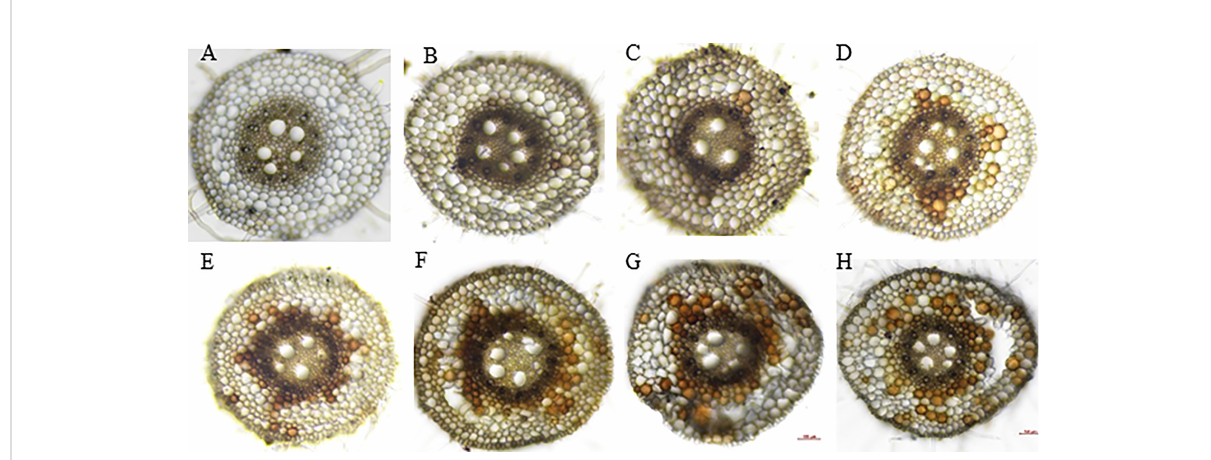
FIGURE 8 DAB staining for H 2 O 2 signal. Upper panel: H-195; Bottom panel: H-242. (A, E) , (B, F) , (C, G) and (D, H) : waterlogging for 1 to 4 days,